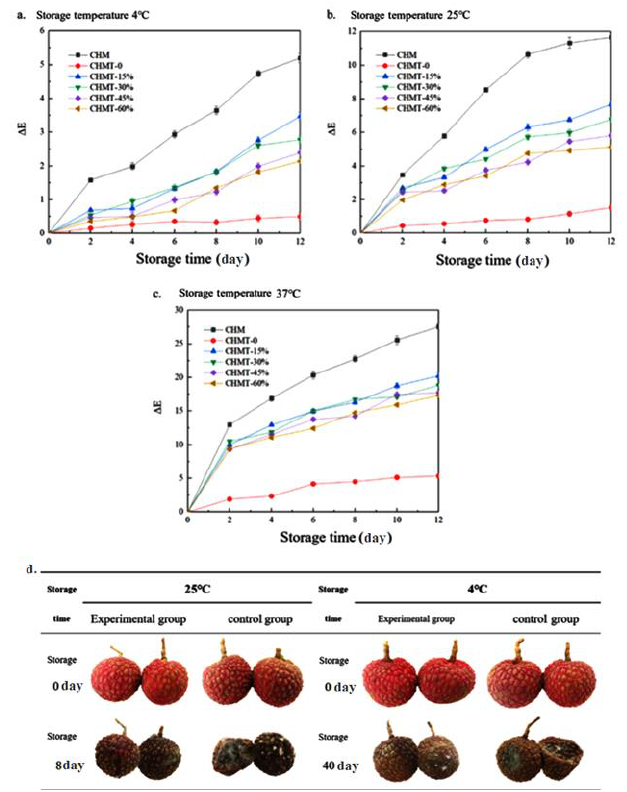
Figure 5. ( a – c ) Color stability of double-layer antibacterial chromogenic materials during storage; ( d ) Comparison of images of litchi before and after storage.